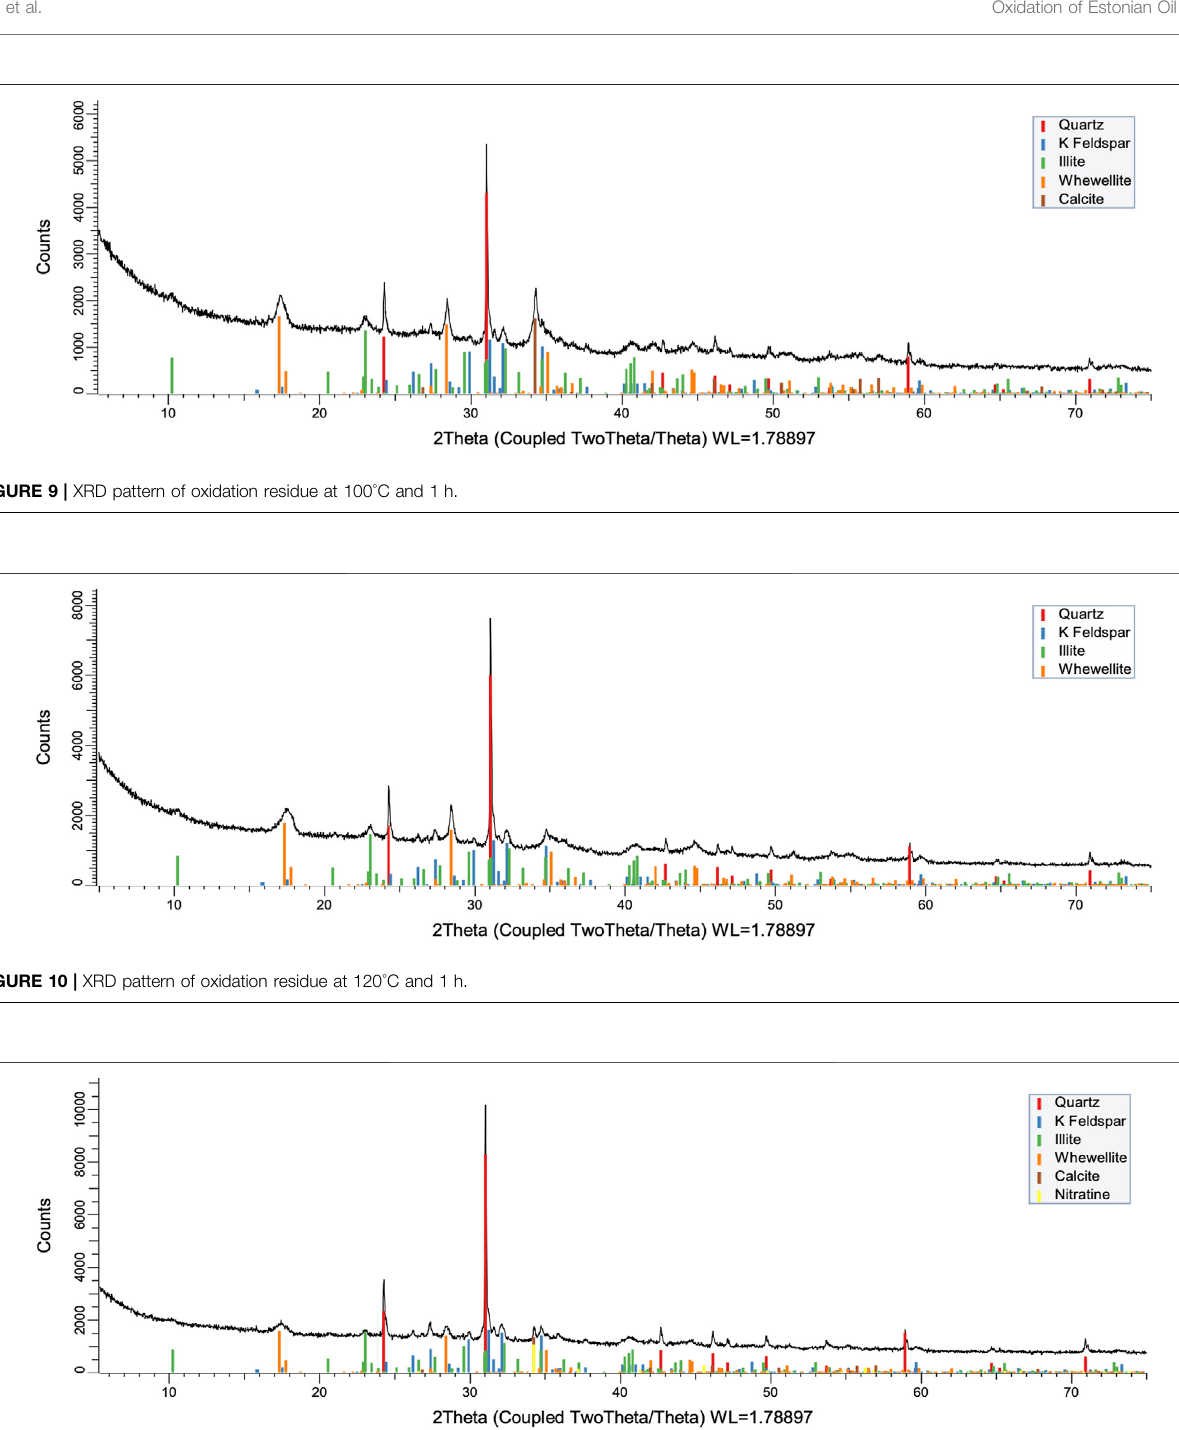
FIGURE 11 | XRD pattern of oxidation residue at 100 ° C and 24